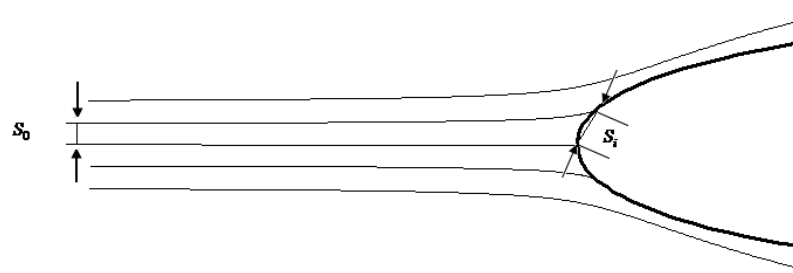
Figure 2. Calculation of the collection coe ffi cient based on the Lagrangian method.